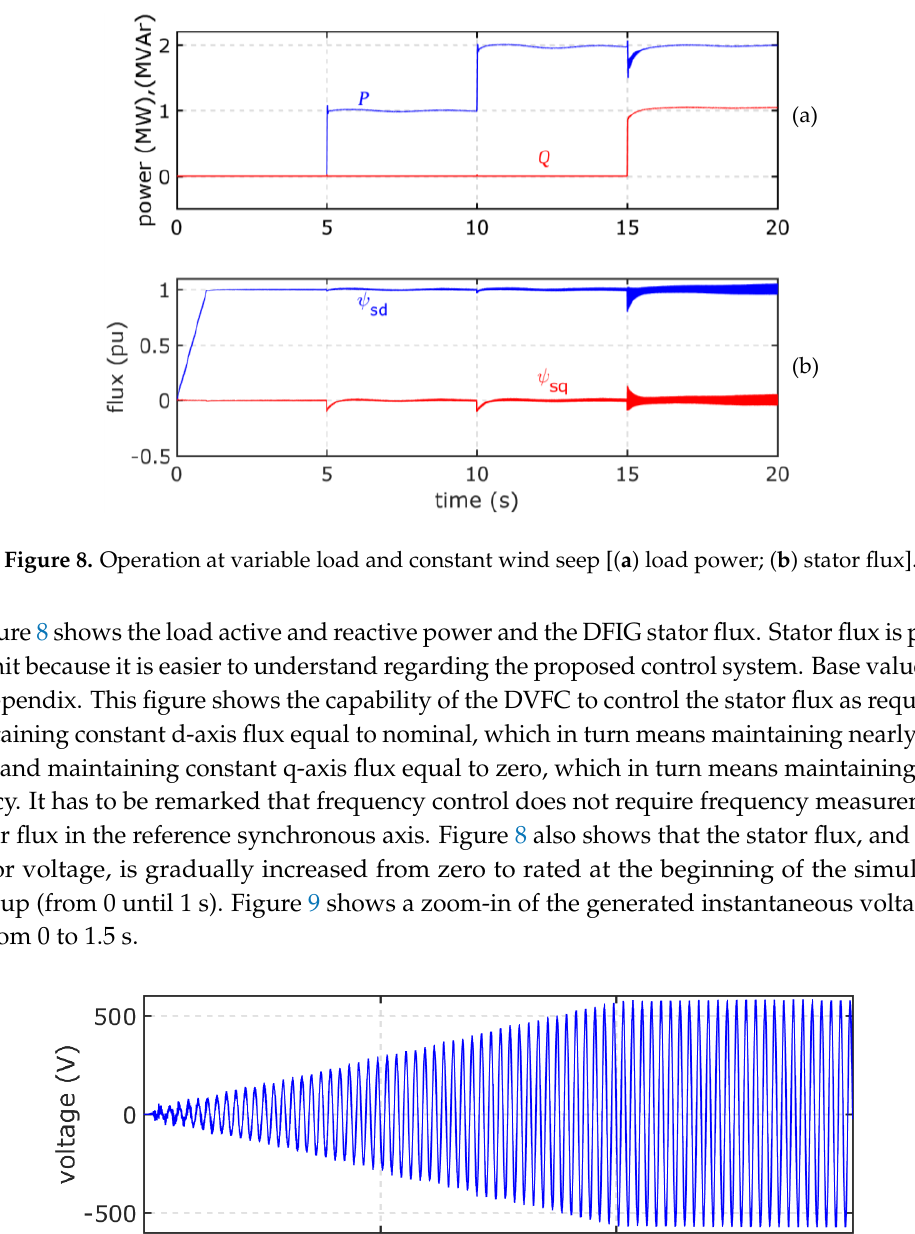
Figure 9. Voltage generation during start-up.